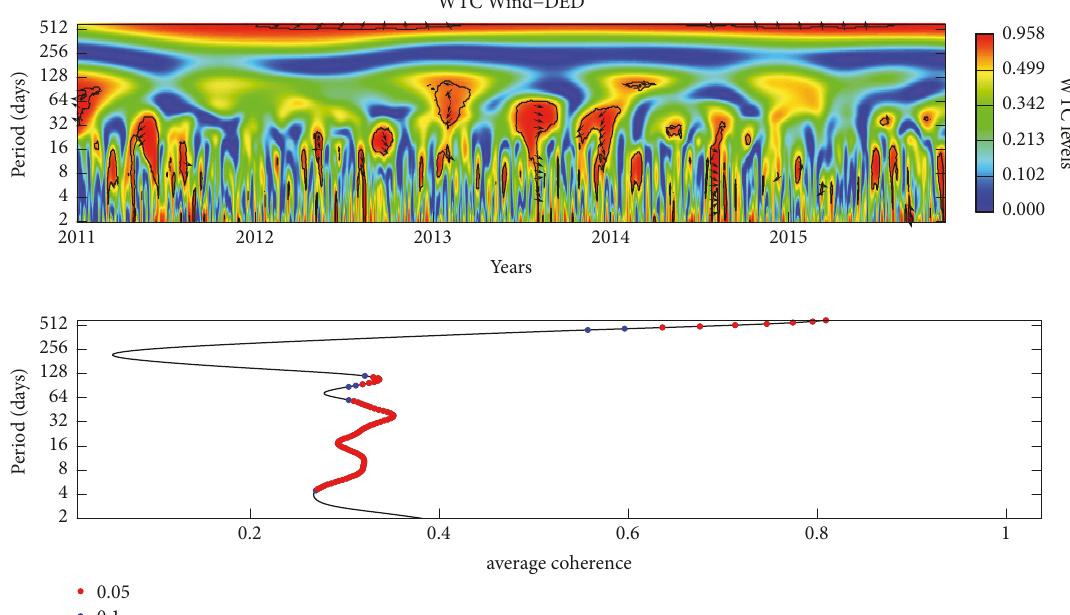
Figure 5: WTC, phase analysis, and average coherence between the wind speed and the daily electricity demand. The black lines show area with 95% of confidence while red and blue points depict the points of 5% and 10% significance